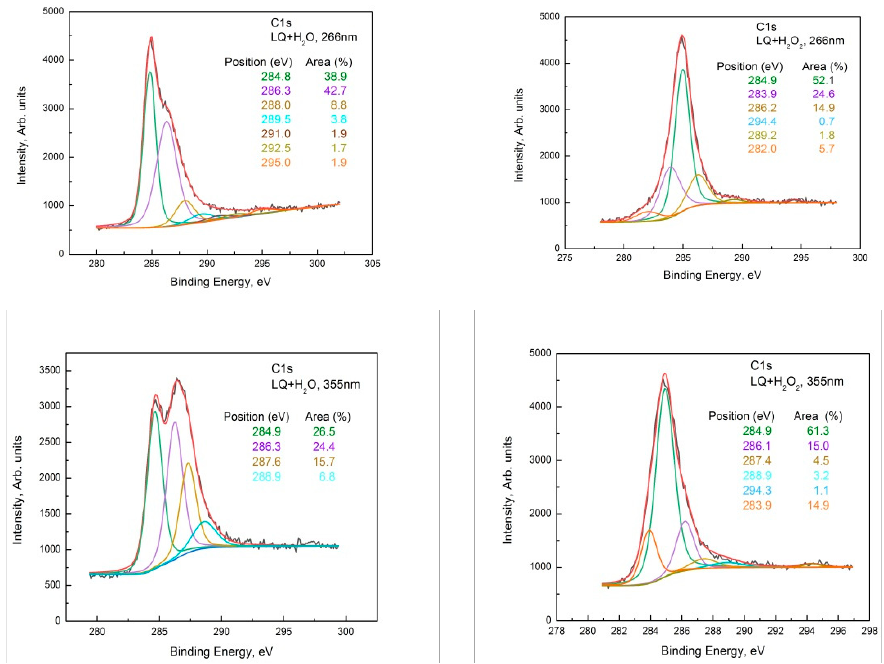
Figure 4. Deconvolution of the C1s line of the XPS spectrum taken from the LQ pristine, LQ+H 2 O, and LQ+H 2 O 2 sediments for both wavelengths, 266 nm and 355 nm.